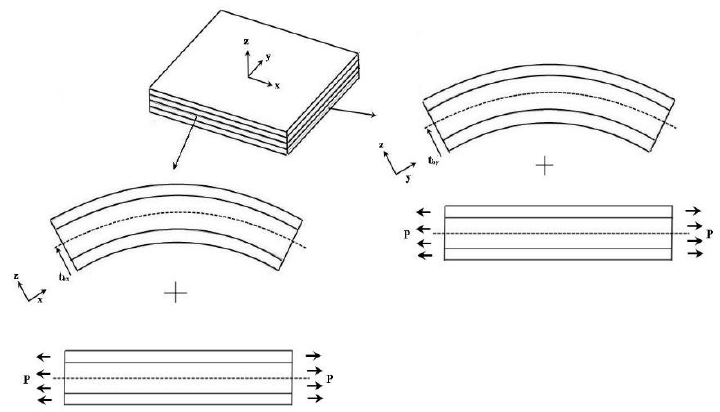
Figure 1. Strain in composite laminate decomposed into uniform and bending components.